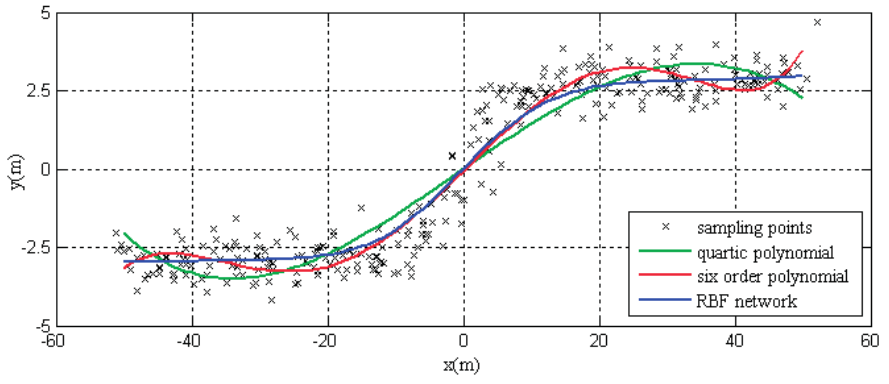
Figure 9. The fitting results of the RBF network and polynominal function.